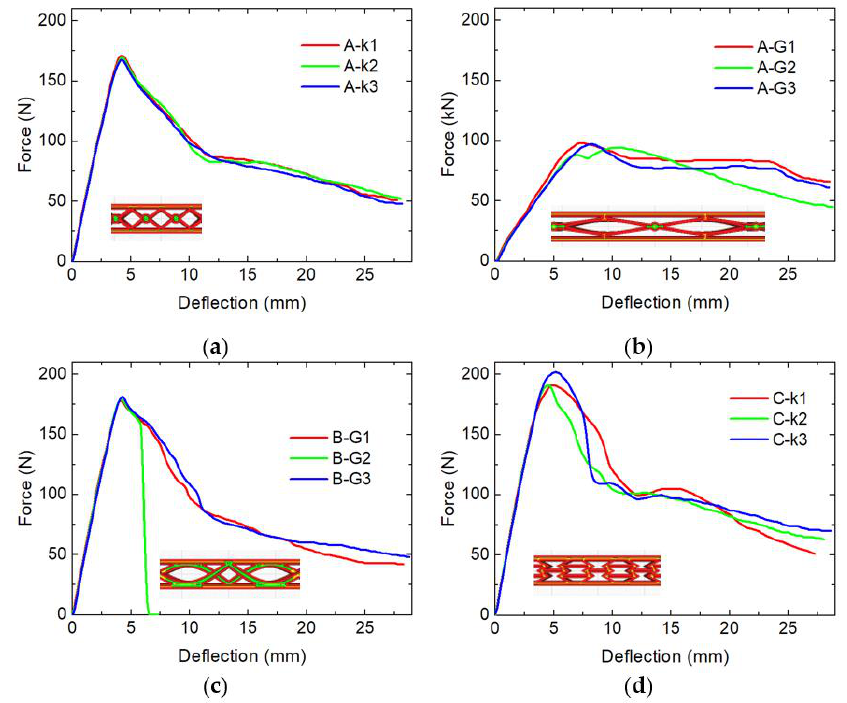
Figure 1. Maximum bending tests of the first set of samples: ( a ) specimens A-k; ( b ) specimens A-G; ( c ) specimens B-G.; ( d ) specimens C-k. ( c ) specimens B-G.; ( d ) specimens C-k.